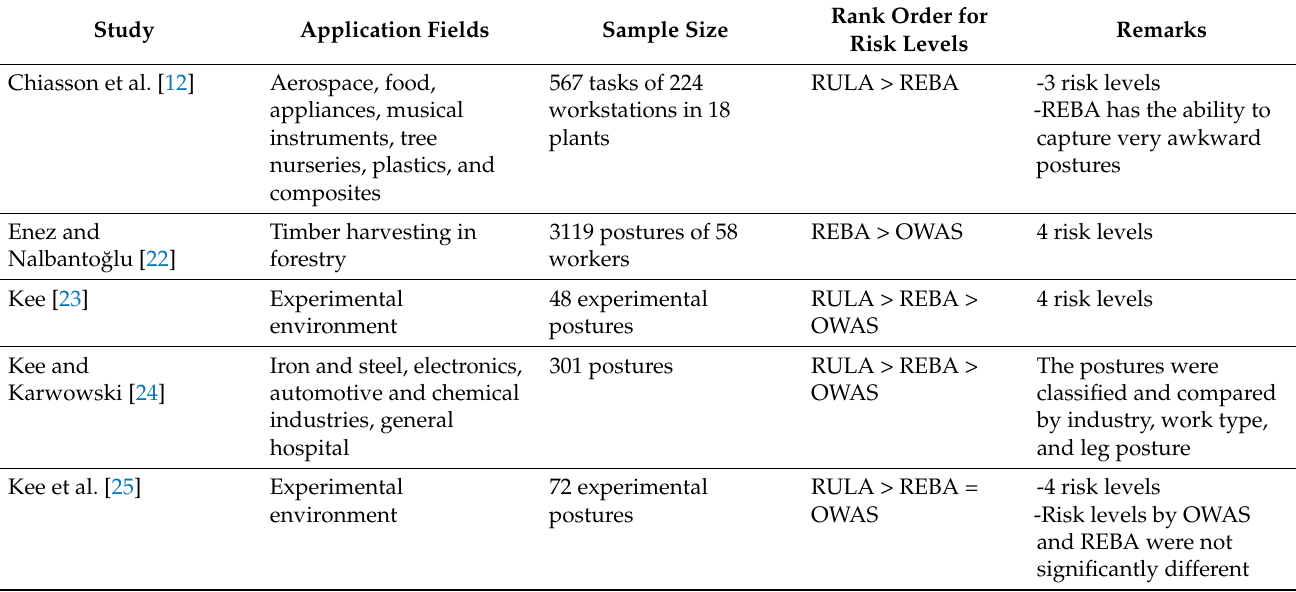
Table 2. Risk levels by